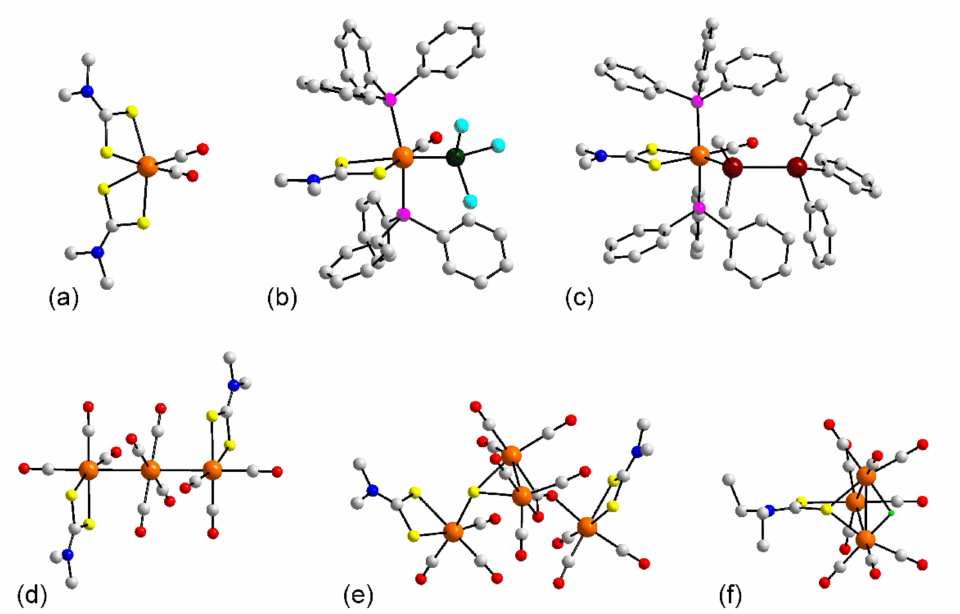
Figure 10. Molecular structures of osmium complexes: ( a ) Os( L 8 ) 2 (CO) 2 ( 157 ), ( b ) (PPh 3 ) 2 Os(SiCl 3 )( L 8 ) (CO) in the crystal of 158 , ( c ) (PPh 3 ) 2 Os(SnMe 2 SnPh 3 )( L 8 )(CO) in 170 , ( d ) Os 3 ( L 8 ) 2 (CO) 10 ( 173 ), ( e ) Os 4 ( L 8 ) 2 (CO) 12 (CO 2 )(S) in 174 , and ( f ) Os 3 (H)( L 24 )(CO) 9 ( 176